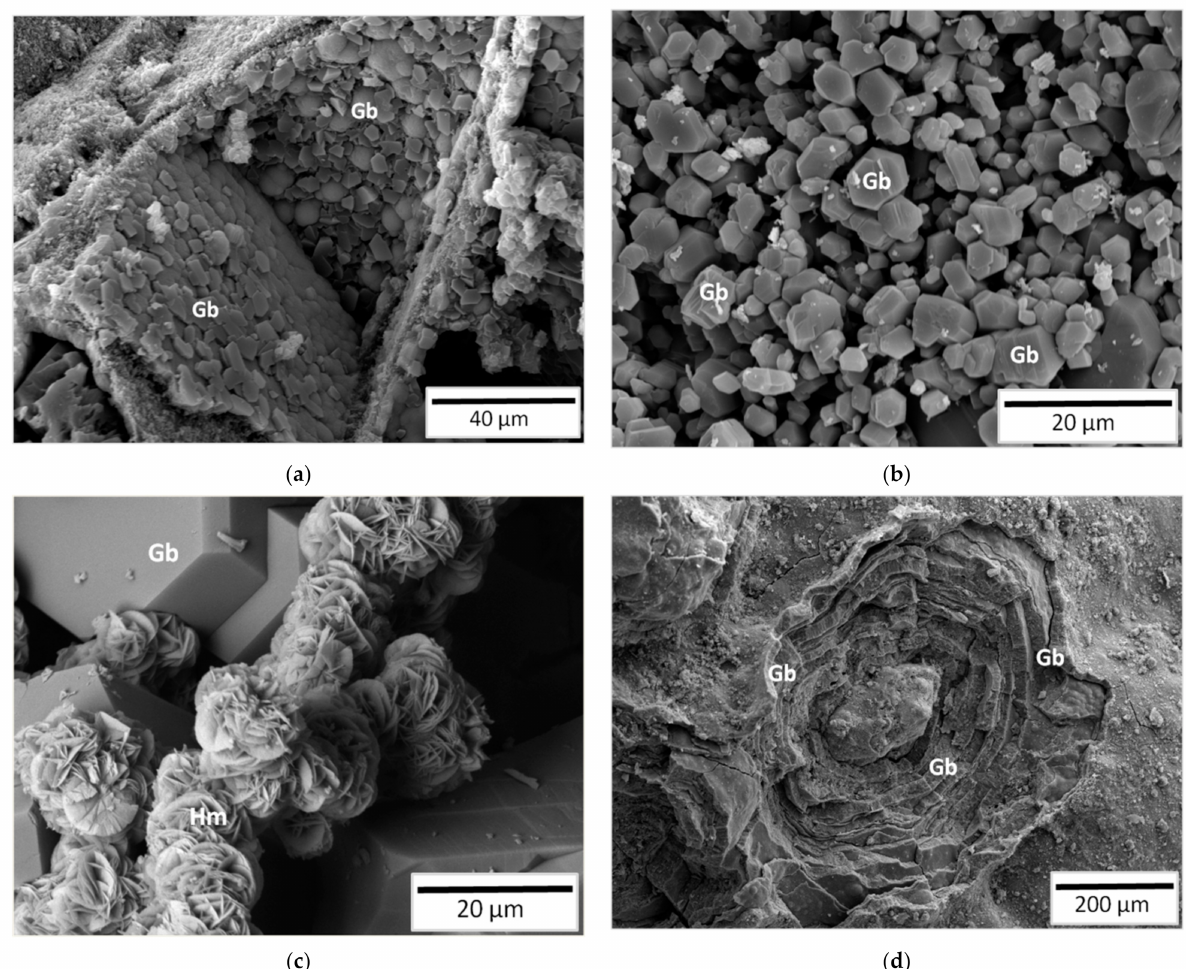
Figure 6. SEM images: short columnar gibbsite crystals ( a ), brushed crystalline gibbsite ( b ), gibbsite and hematite ( c ), section of multilayer gibbsite film ( d ). Gb: gibbsite, Hm: